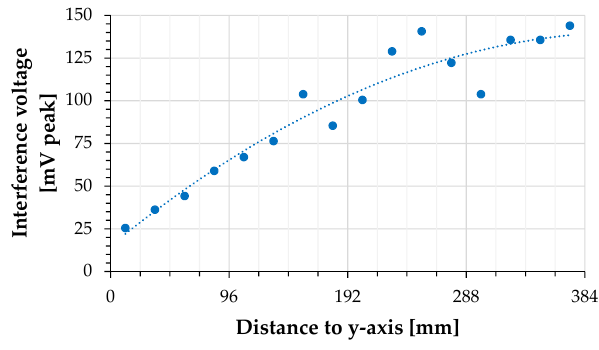
Figure 5. Position dependence of the interference voltage when using sensor coil 1.